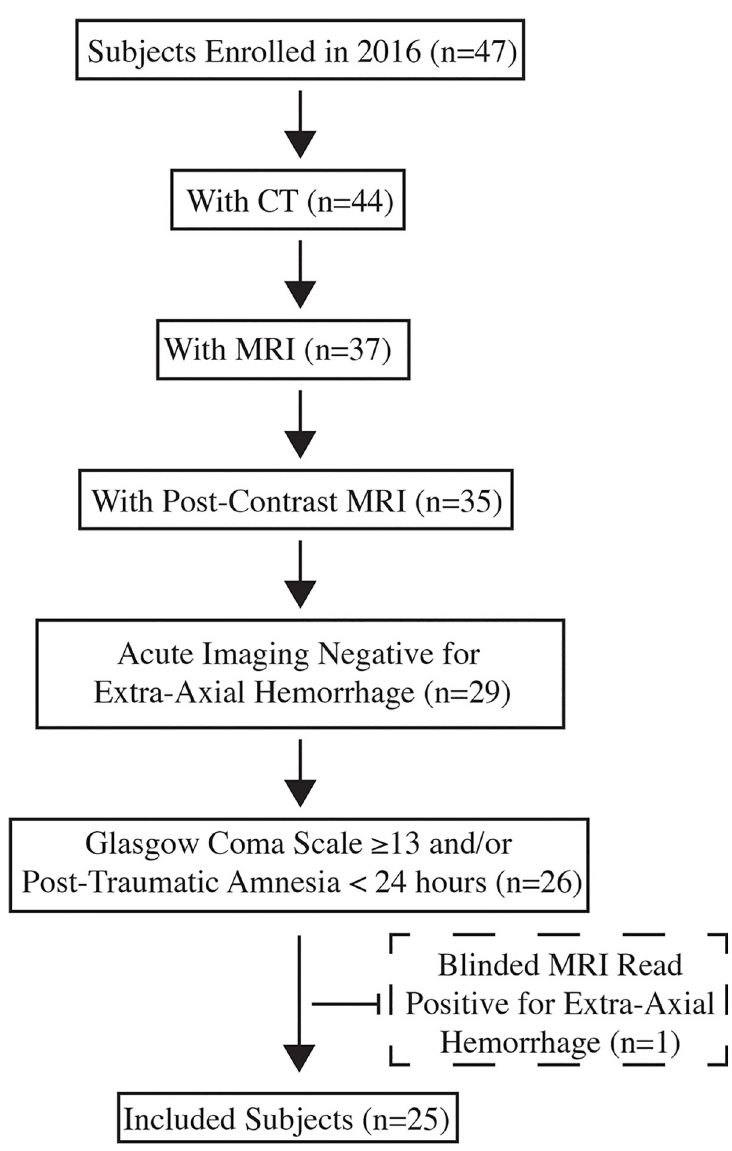
Fig 2. Flowchart demonstrating how the final inclusion set was obtained. Extra-axial hemorrhage was defined as subarachnoid hemorrhage, subdural hematoma, and/or epidural hematoma.